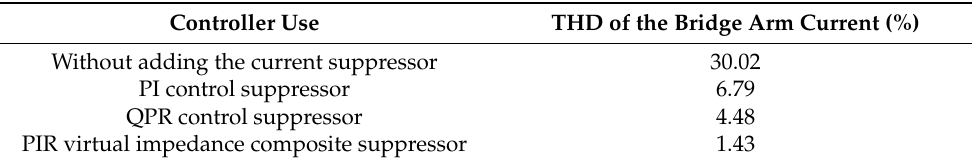
Table 3. Comparisons of the THD using different methods.